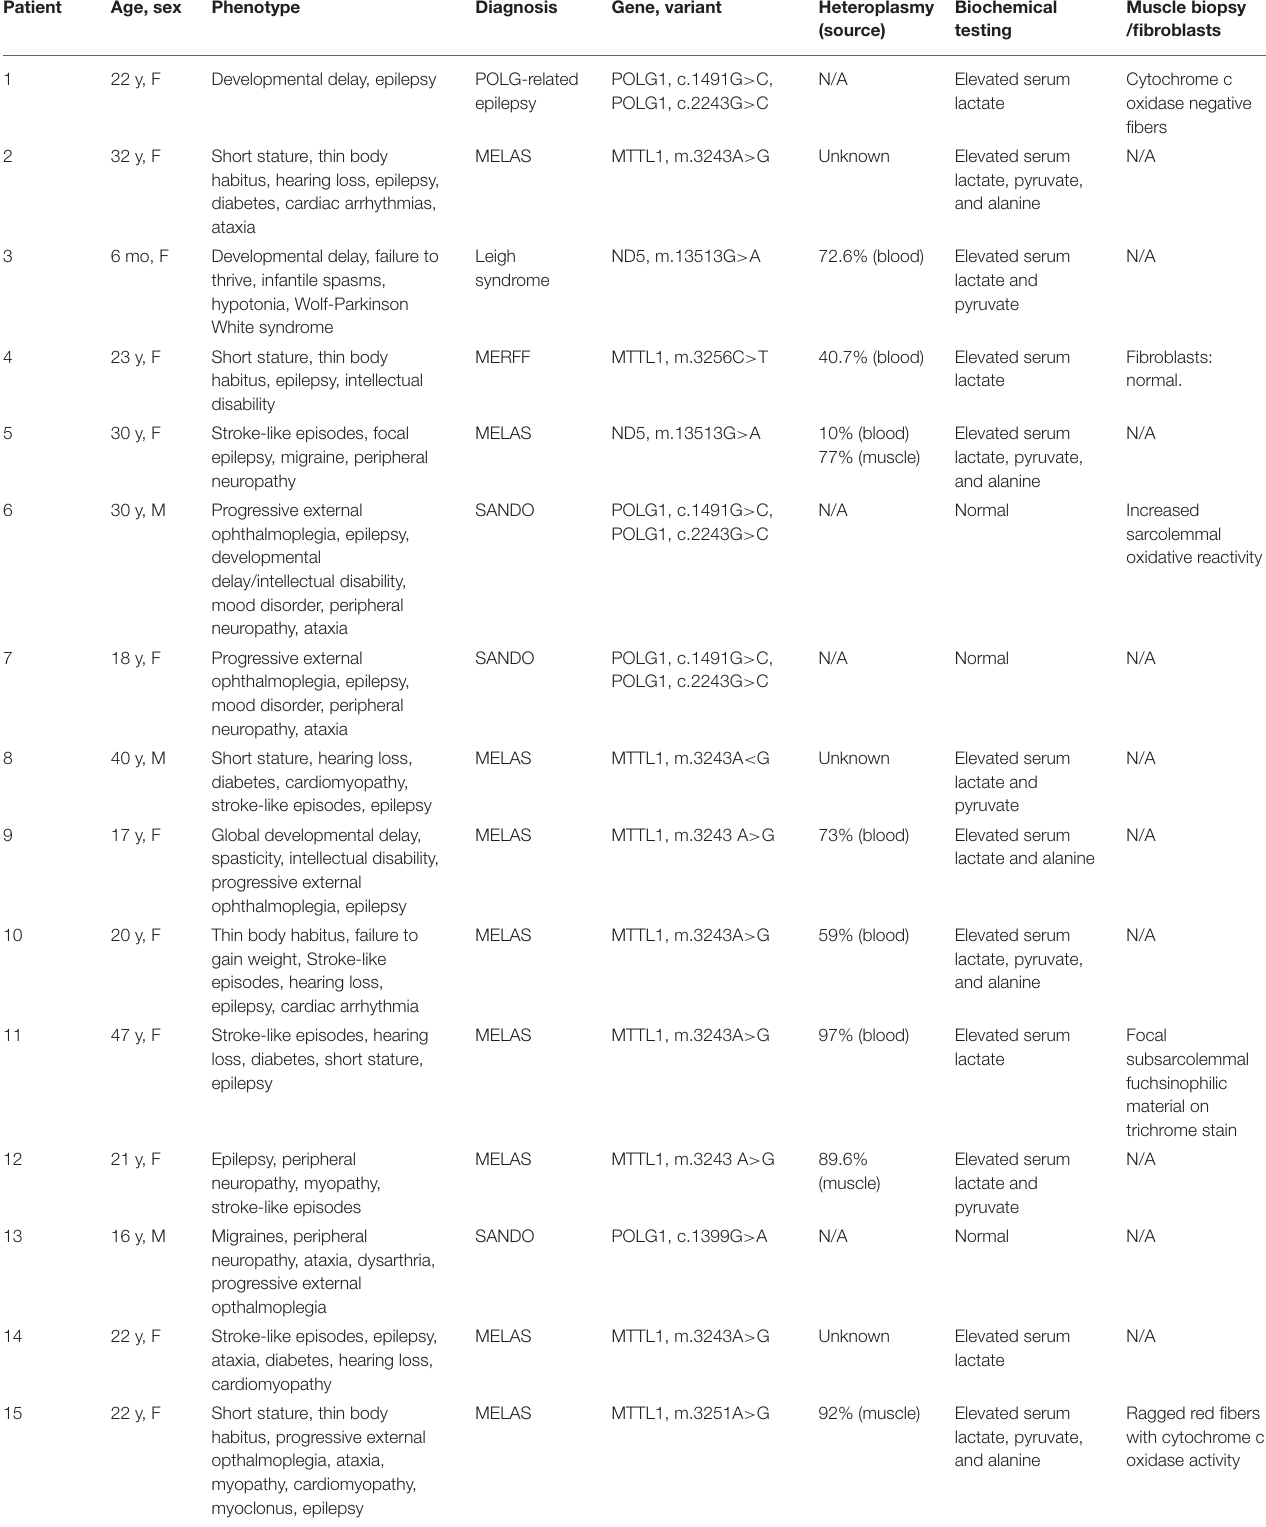
TABLE 2 | Phenotypes, genetic, and biochemical testing of patient.